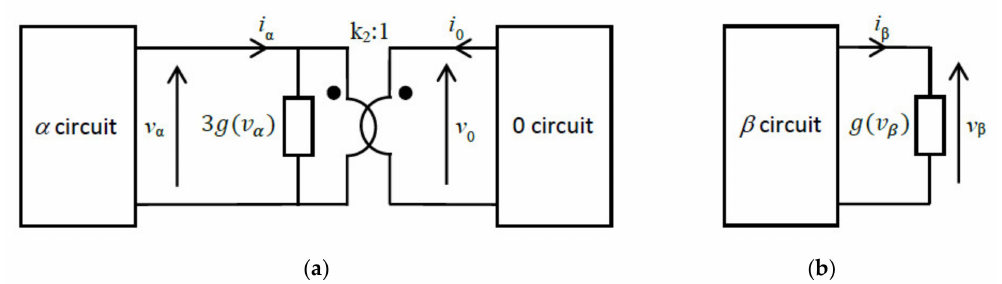
√ 2 and ( b ) an uncoupled